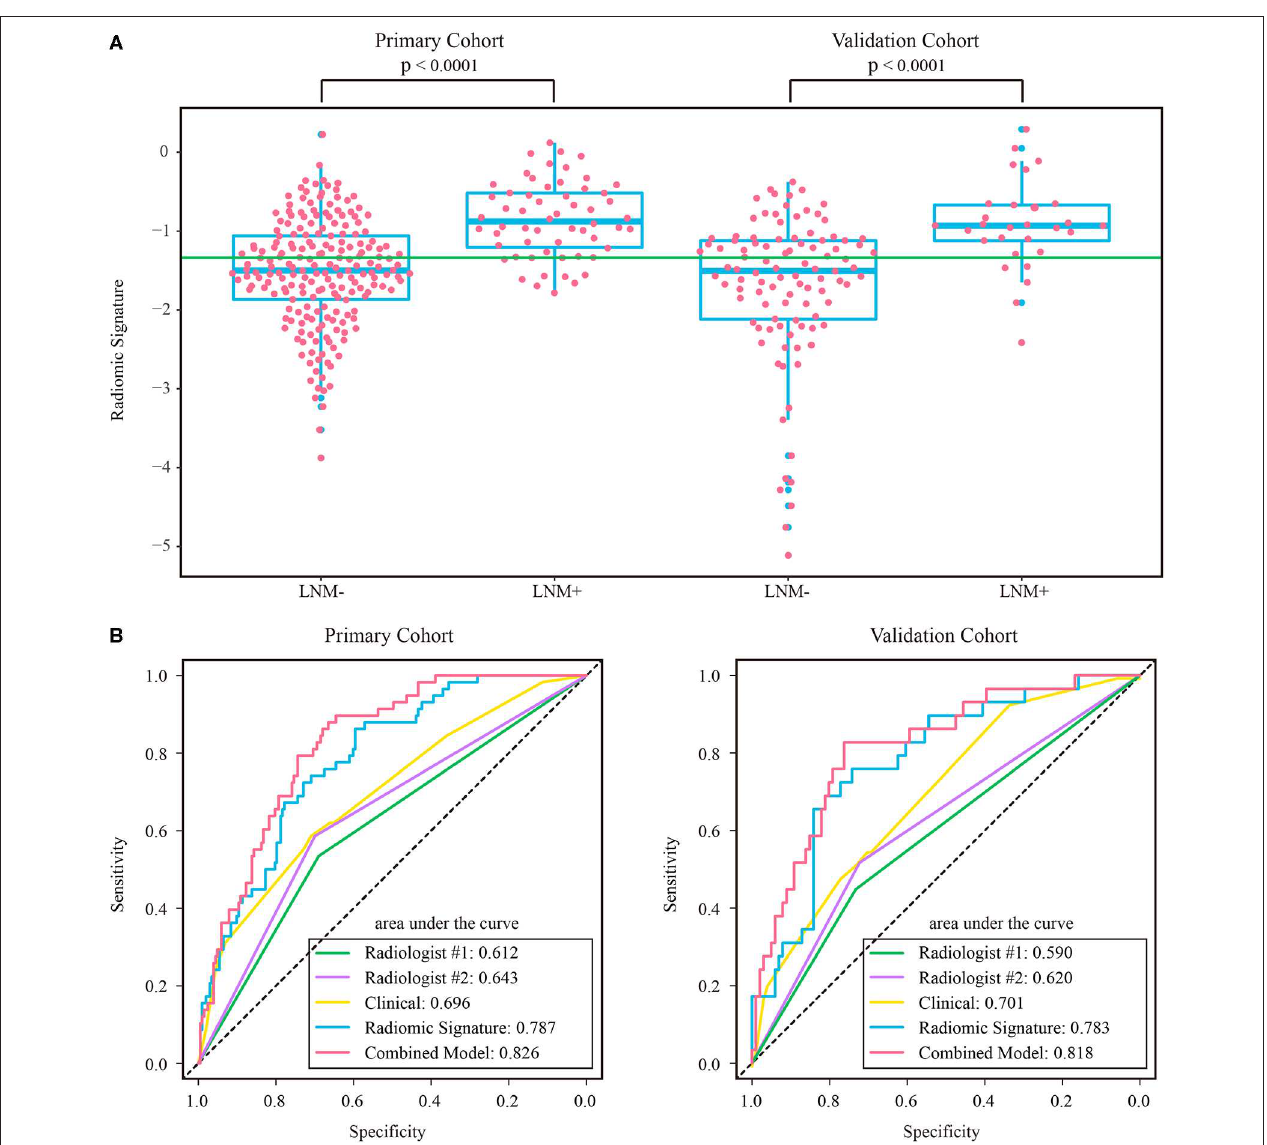
FIGURE 3 | (A) Distribution of radiomic signature in the primary and validation cohorts, where the green line indicates the Youden cutoff in the primary cohort, and the p -value was calculated using Wilcoxon rank-sum test. (B) ROC curves of radiologists’ and prediction models. LNM + , lymph node metastasis; LNM-, lymph node non-metastasis; ROC, receiver operating